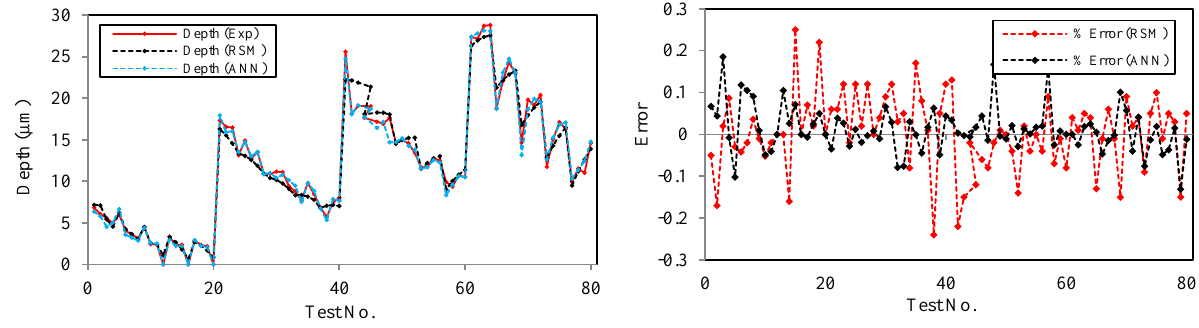
Fig. 6. G. W and % Errors comparison for the ANN and RSM